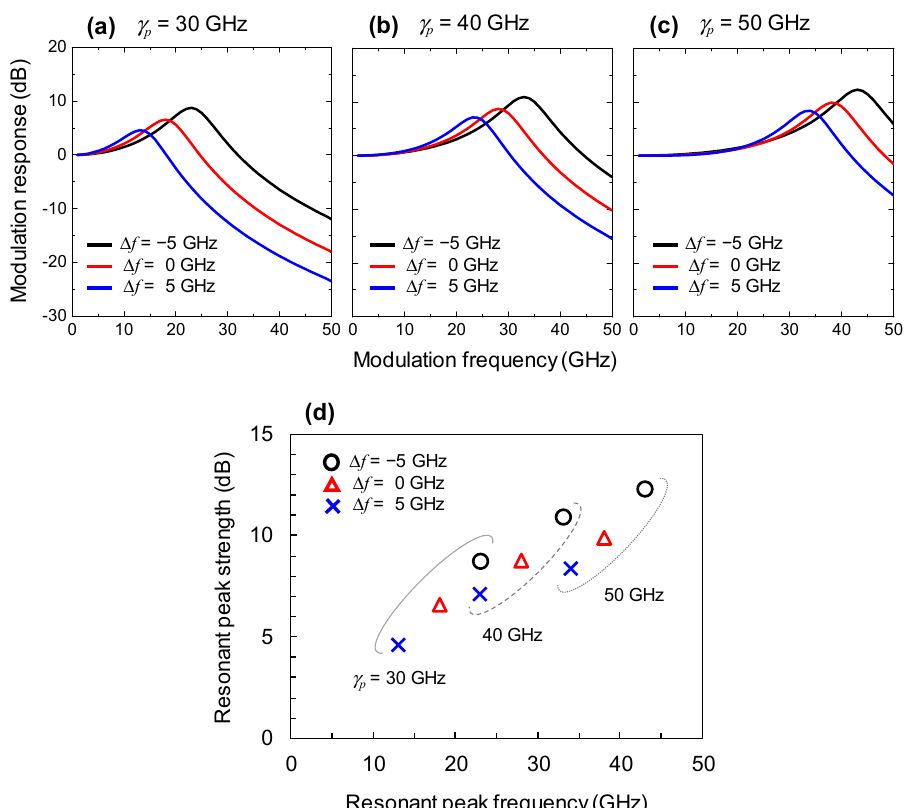
Figure 4. Spin polarization modulation responses of injection-locked spin-VCSELs calculated with IR of 10 dB. ( a ) γ p = 30 GHz; ( b ) γ p = 40 GHz; ( c ) γ p = 50 GHz. Black, red, and blue curves indicate results for ∆ f of − 5, 0, and 5 GHz, respectively. ( d ) Resonant peak strengths in relation to resonant peak frequencies observed in spin polarization modulation responses. Values for ∆ f of − 5, 0, and 5 GHz are indicated by the circles, triangles, and crosses, respectively. Values for γ p of 30, 40, and 50 GHz are grouped by solid, dashed, and dotted curves, respectively.